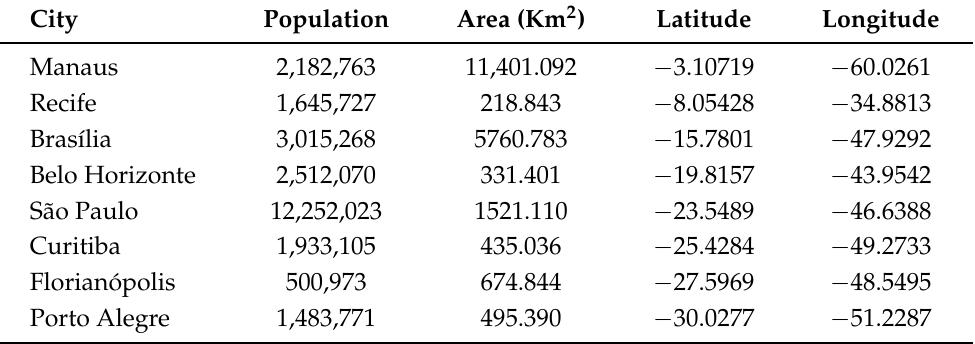
Table 2. Characteristics of the eight